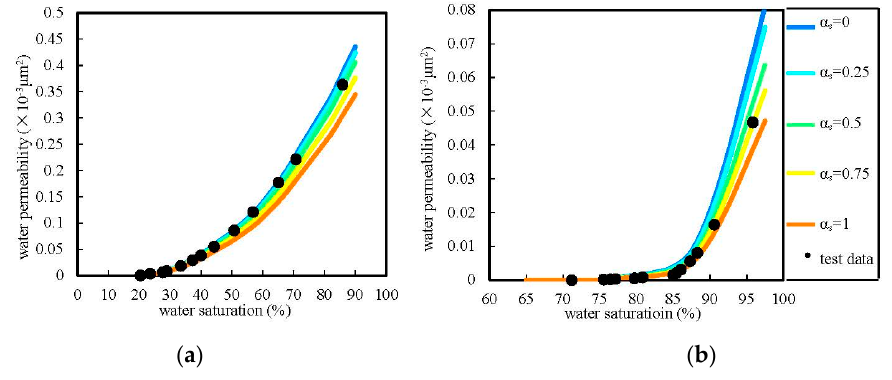
Figure 8. Water phase permeability curves of tight sandstone cores 24 # and 69 # . ( a ) Water phase permeability curve core 24 # . ( b ) Water phase permeability curve core 69 # .